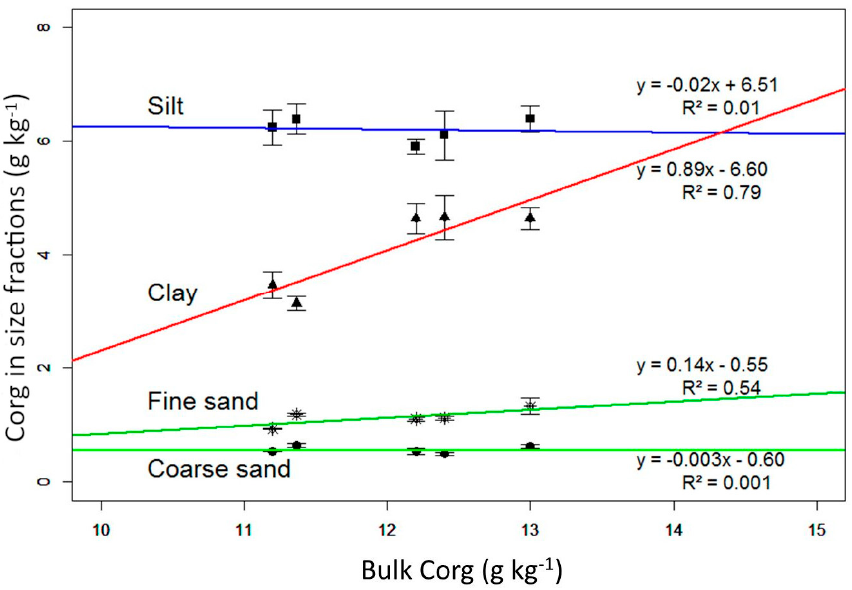
Figure 2. Relationship between mean (± standard error, n = 3) organic C (Corg; g Corg·kg − 1 soil) in bulk soil and mean Corg (g Corg·kg − 1 soil) in each size fraction. Linear regression functions are reported.